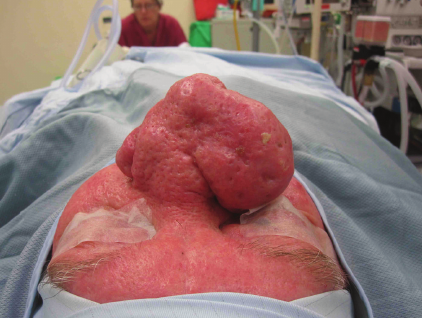
Figure 6: Case 3, intraoperative sky view.